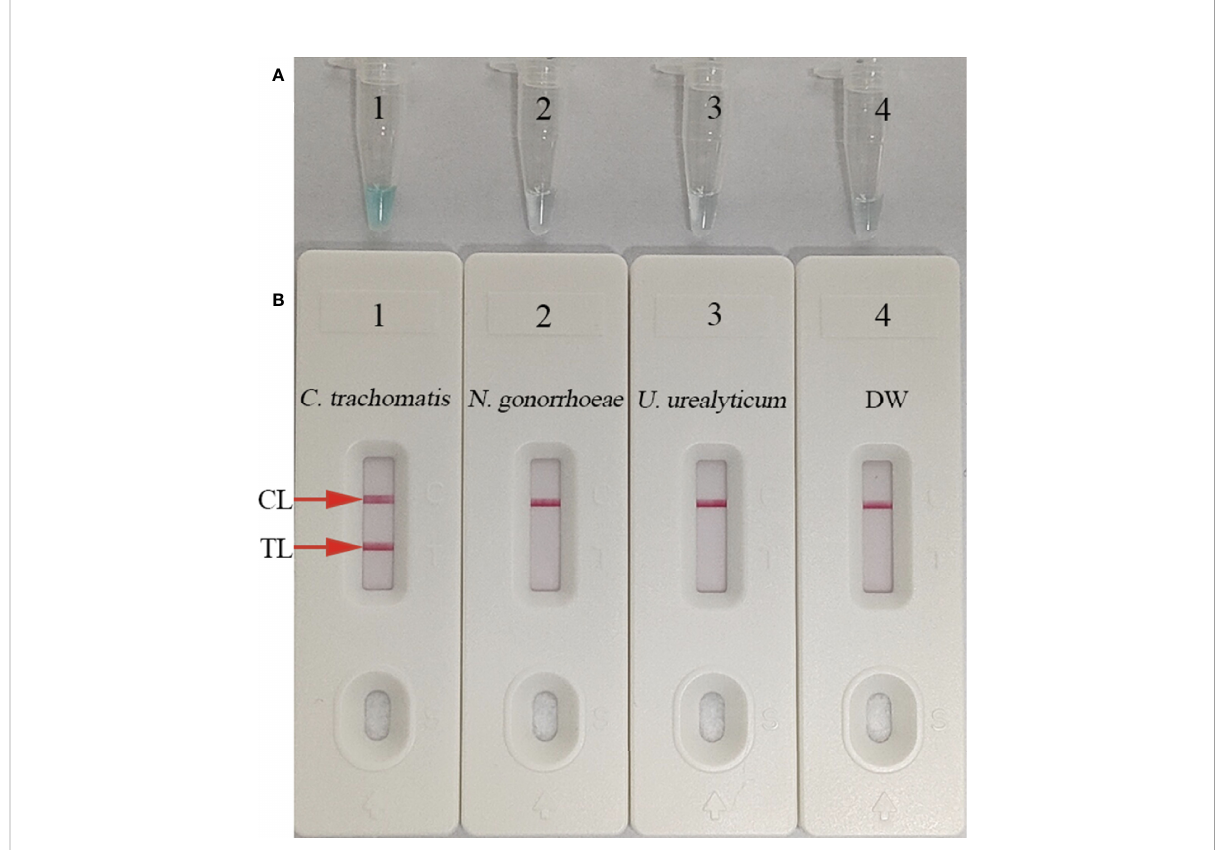
FIGURE 3 Con fi rmation and veri fi cation of (C) trachomatis -MCDA products. C trachomatis -MCDA products were measured simultaneously using malachite green (MG) (A) and AuNPs-LFB (B) . Tube 1/Biosensor 1: positive result for C trachomatis ompA standard plasmids; Tube 2/Biosensor 2: negative result for Neisseria gonorrhoeae ; Tube 3/Biosensor 3: negative result for Ureaplasma urealyticum ; Tube 4/Biosensor 4: blank control (distilled water, DW). TL: test line; CL: control